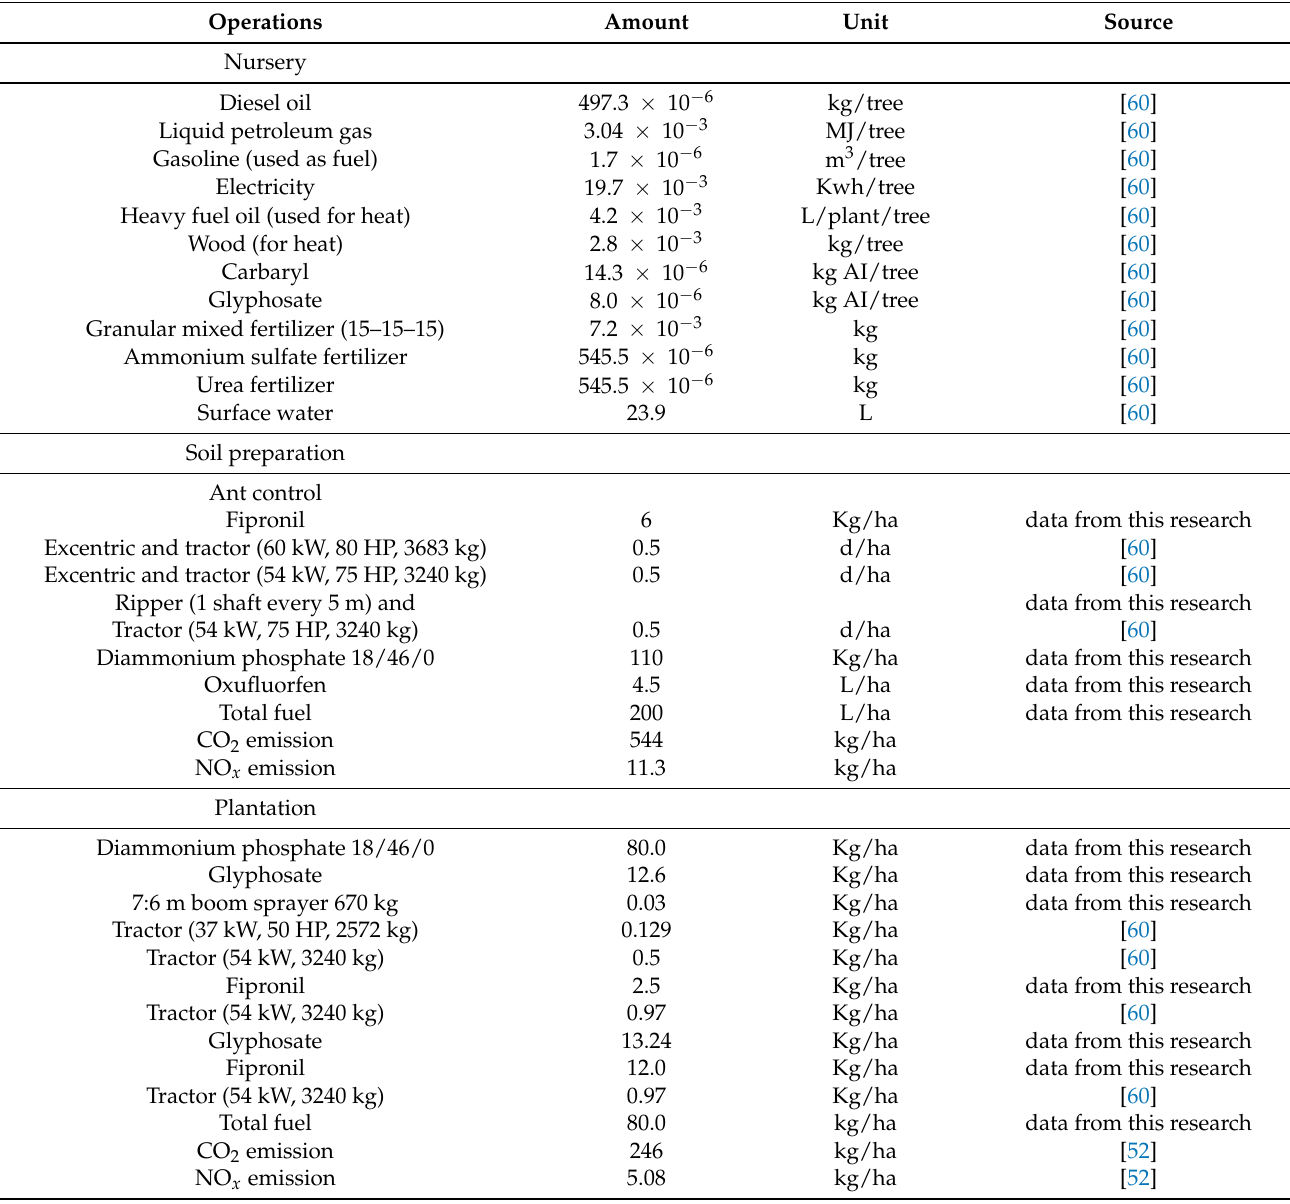
Table A1. Life cycle inventory of solid wood from 21 years Eucalyptus grandis plantations for sawmill and pulp mill. Operations